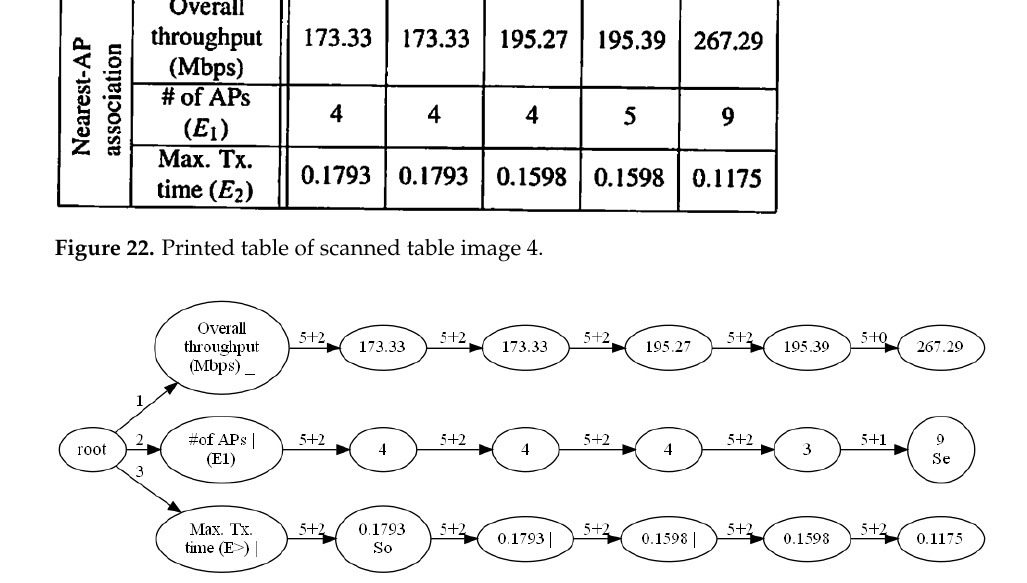
Figure 23. Tree for scanned table image